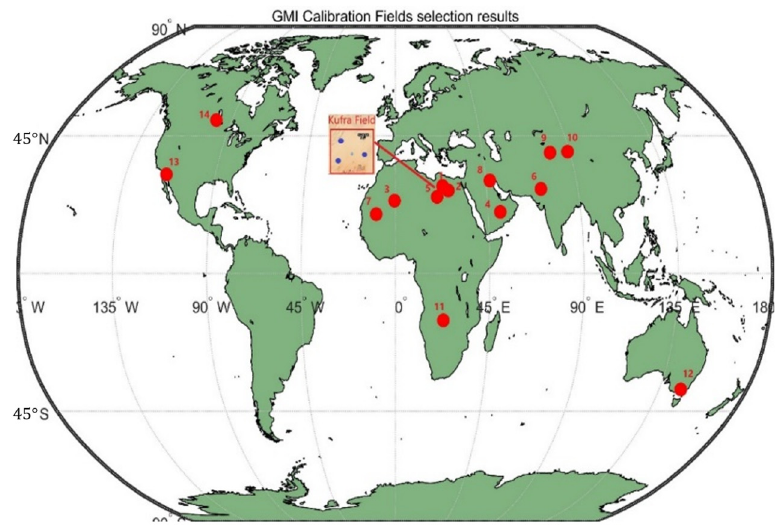
Figure 11. GMI digital calibration field network selection results (red circles and numbers represent the calibration field and its serial number). Table 4. Statistics on the evaluation parameters of the GMI calibration field in 2018. Num Calibration field